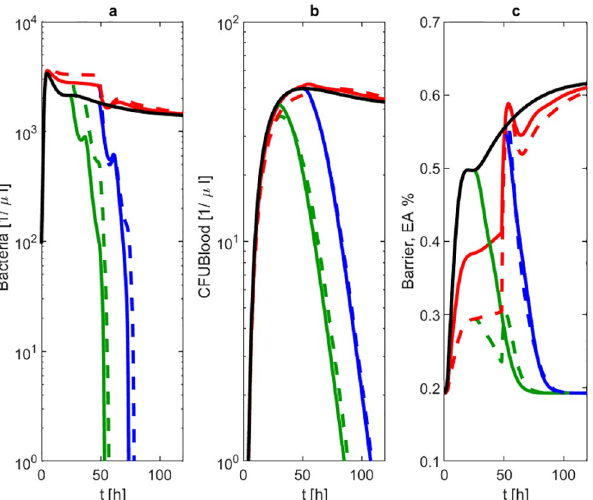
Fig 9. Prediction scenarios. We simulated the outcome of combined 20 mg/kg NOX-D19 and antibiotic treatment starting 24h (green dashed line) or 48h (blue dashed line) after infection and compared the results with no treatment (black solid line), antibiotic treatment alone 24h (green solid line) or 48h (blue solid line) after infection or 2 mg/kg (red solid line) respectively 20 mg/kg (red dashed line) NOX-D19 alone. Time series of pneumococcal population in BAL (a) and blood (b) and barrier function (c) are displayed. Cure is only achieved in scenarios with antibiotic treatment. Bacteremia is smallest in case of 20 mg/kg NOX-D19 combined with early antibiotic treatment.